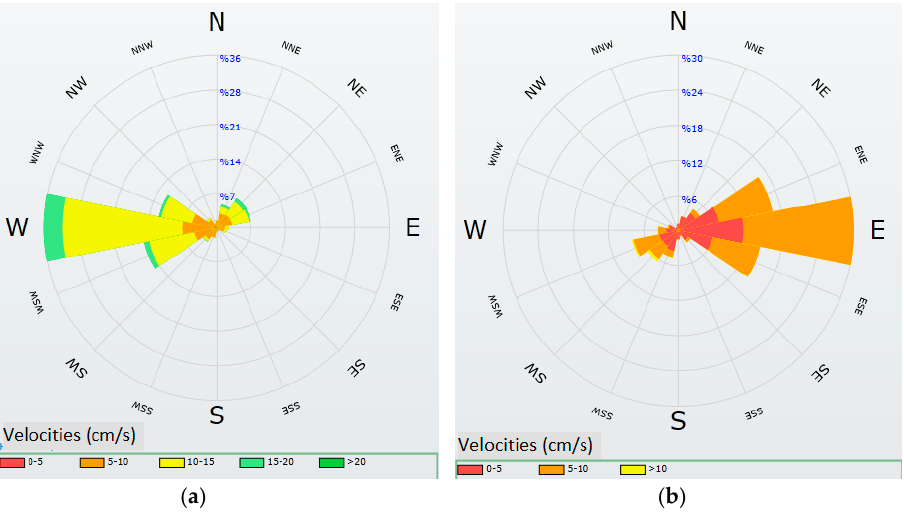
Figure 7. Current roses: ( a ) sea surface layer and ( b ) bottom layer from ECMWF for 2012–2016 for coordinates 39.50° N–26.90° E [33]. Table 2. Wind velocities and occurrence frequency [33].